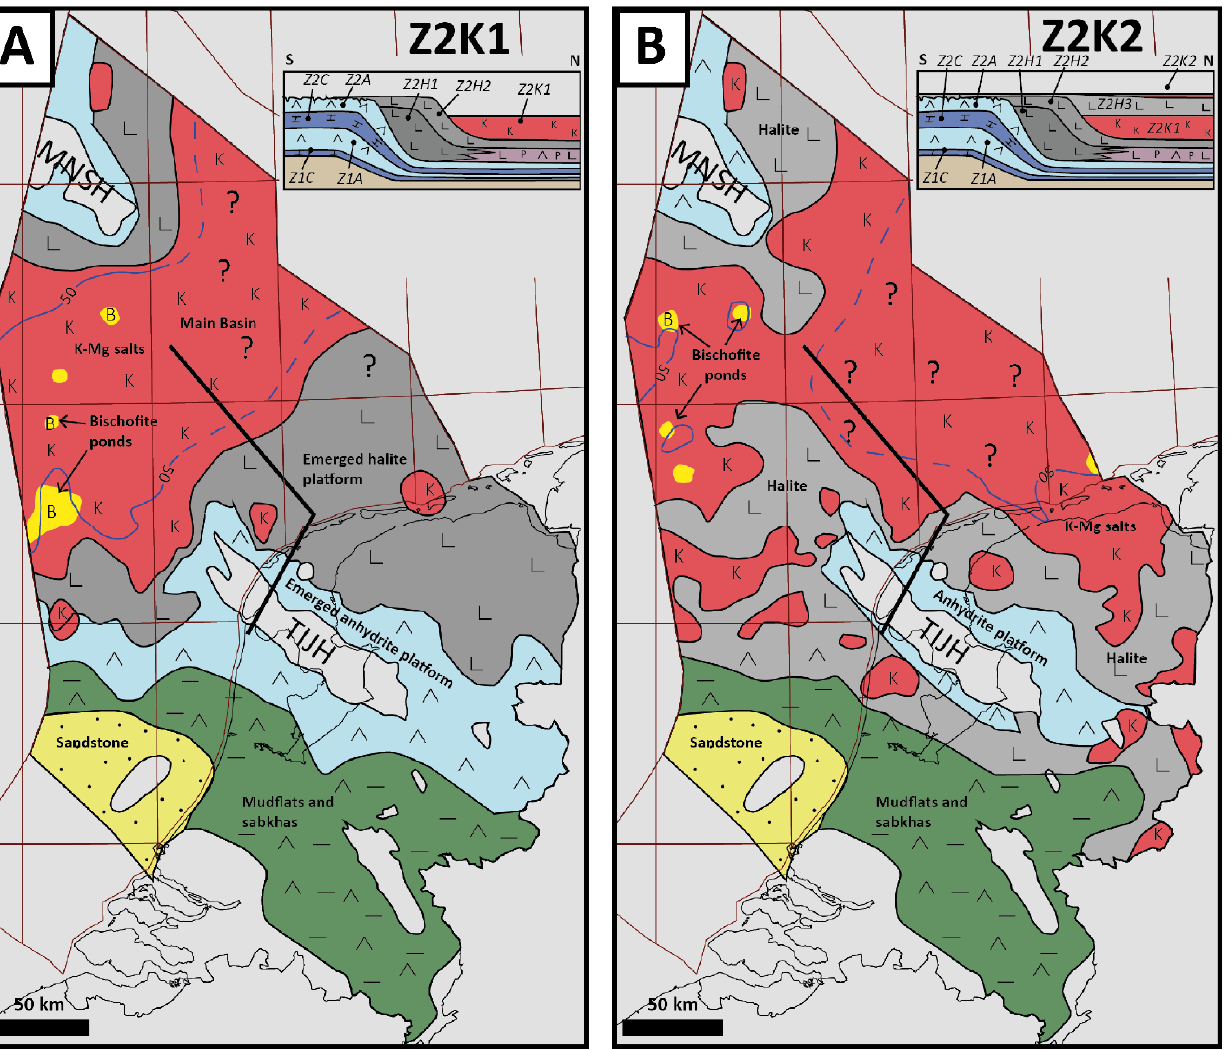
Figure 9. Facies and isopach map of the Z2K1 ( A ) and Z2K2 ( B ) units (modified after [8]) with conceptual sections illustrating the depositional setting (upper right).